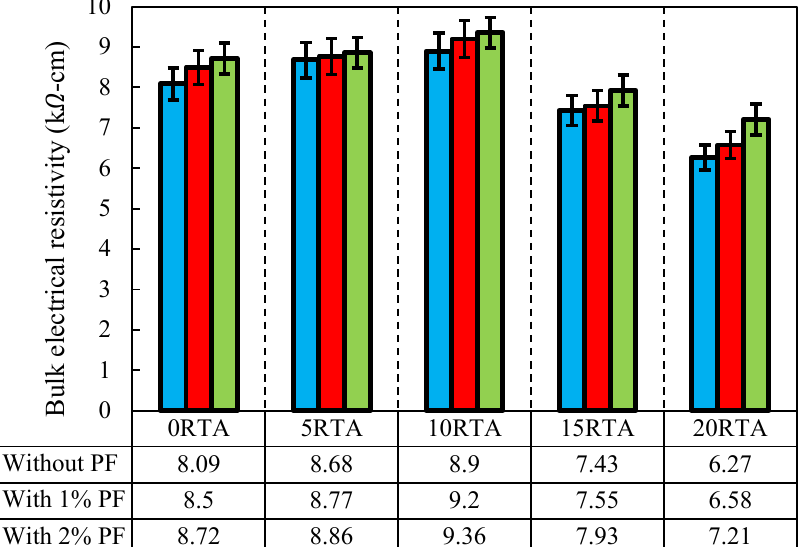
Figure 18. Impact of PF and RTA on the bulk electrical resistance.